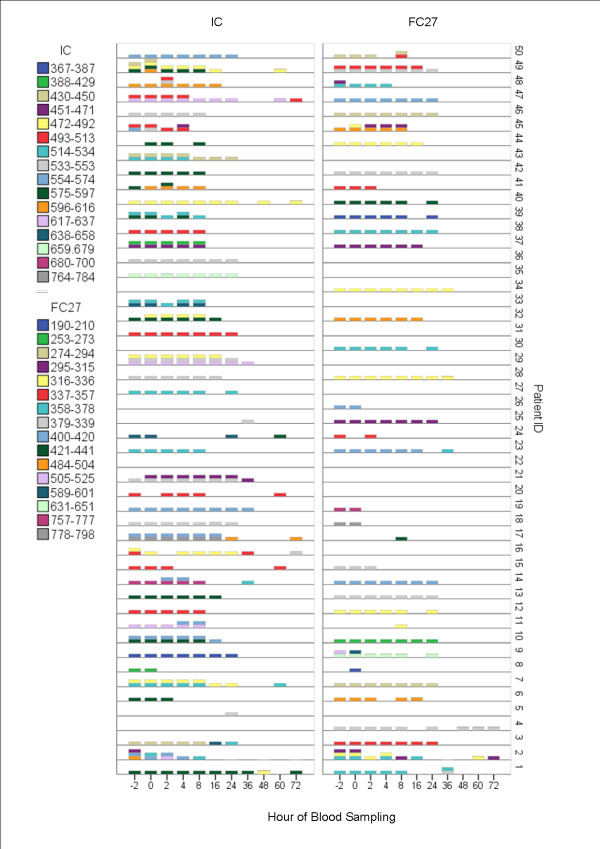
Distribution of detectable msp2genotypes over time for each study participant